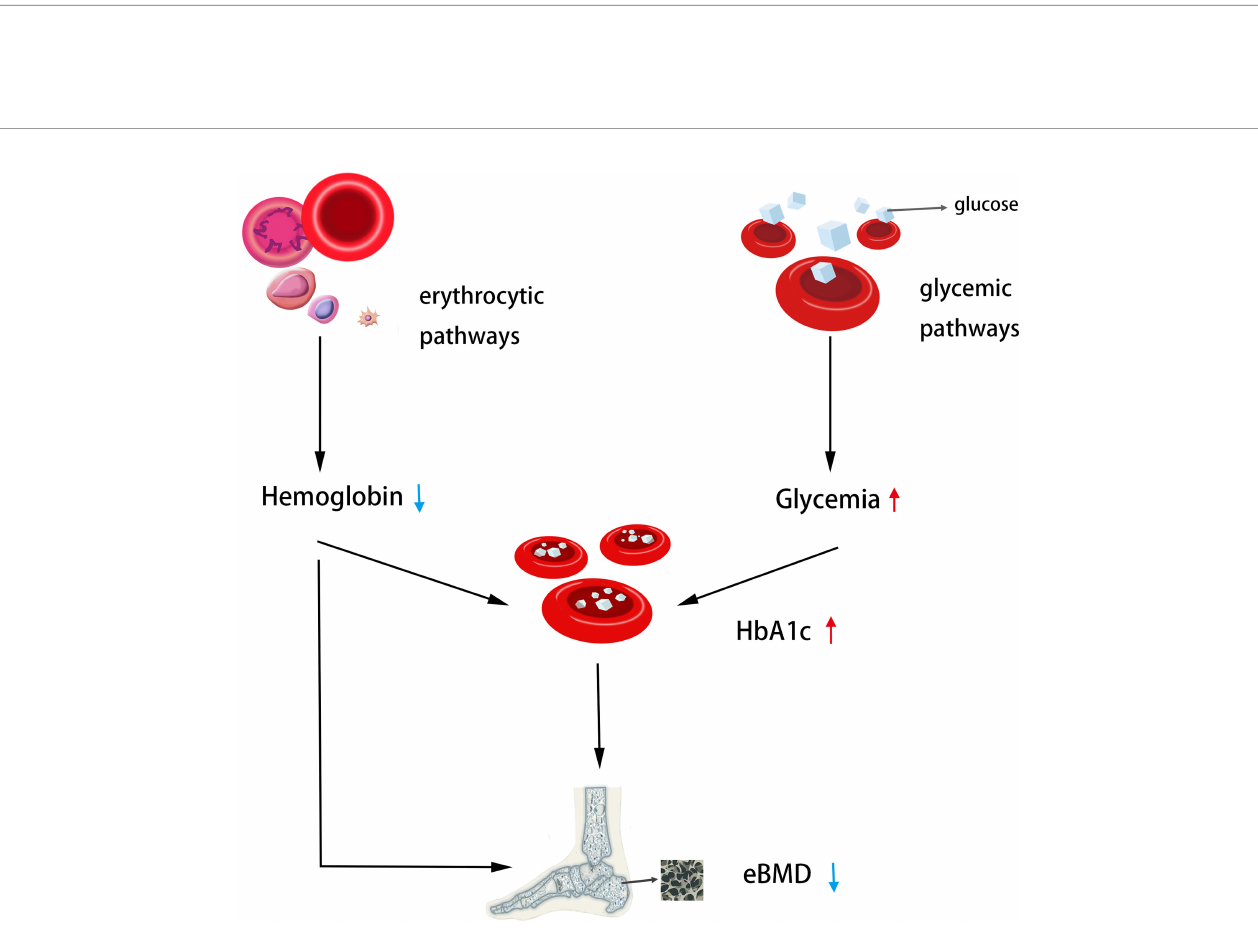
FIGURE 4 | The genetic casual effect of HbA1c on eBMD is represented by an MR diagram of glycemic and erythrocytic factors. Generally, increased HbA1C when instrumented by all HbA1c genetic variants was associated with lower heel eBMD; Increased HbA1c when instrumented by erythrocytic HbA1c variants was associated with lower heel eBMD. Moreover, decreased hemoglobin was associated with lower heel eBMD. The causal association of lower Hb with higher HbA1c has been shown in the literature (25), so the MR analysis was not performed.